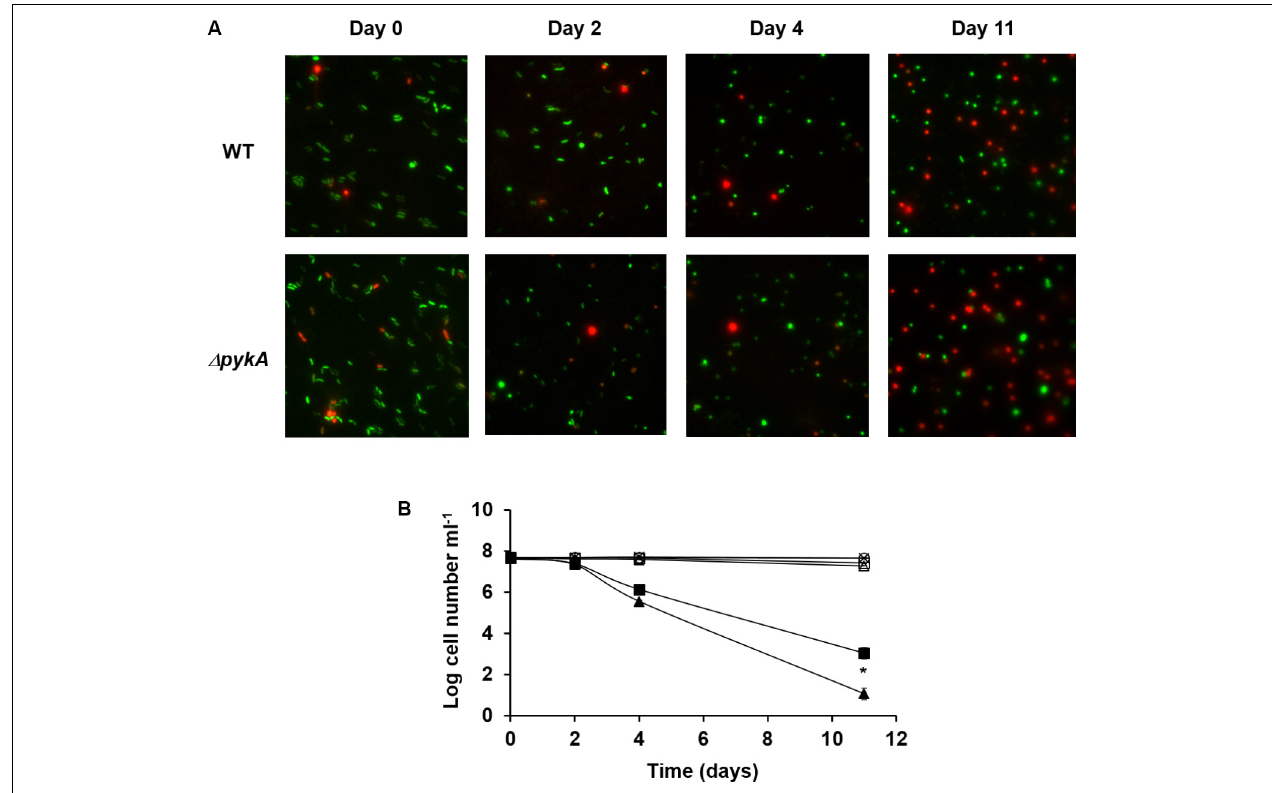
FIGURE 1 | Induction of viable but non-culturable (VBNC) state by Vibrio vulnificus in the artificial sea water on incubation at 4 ◦ C. (A) Microscopic pictures of wild-type V. vulnificus CMCP6 and pykA mutant strains after 0, 2, 4, and 11 days incubation at 4 ◦ C. Samples were stained with the Live/Dead BacLight Bacterial Viability Kit (Life Technologies). The two color fluorescence assay uses green nucleic acid stain that penetrates both live and dead cells, while the red propidium iodide stain is excluded from live cells. Representative data from three independent experiments are shown. (B) Total cell counts, viable cell counts, and plate counts were determined. Plate counts are given in cfu ml − 1 . × , total cell counts of the wild-type V. vulnificus CMCP6 culture; (cid:13) , total cell counts of the pykA mutant culture; (cid:3) , viable cell counts of the wild-type V. vulnificus CMCP6 culture; (cid:49) , viable cell counts of the pykA mutant culture; (cid:4) , plate counts of the wild-type V. vulnificus CMCP6 culture; (cid:78) , plate counts of the pykA mutant culture. The results are presented as the mean ± standard deviations of three independent measurements. Statistical significance for the VBNC cells on Day 11 was determined by Student’s t -test ( ∗ P < 0.05, n =